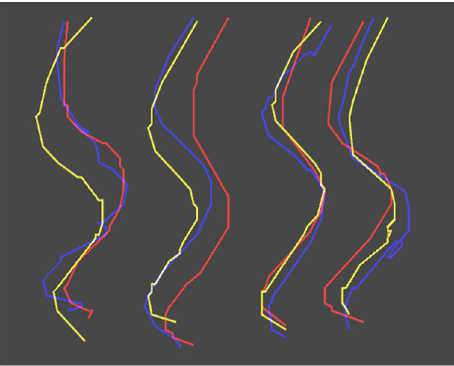
Fig. 25 No warning vs warning; order of experiment: r,s,o